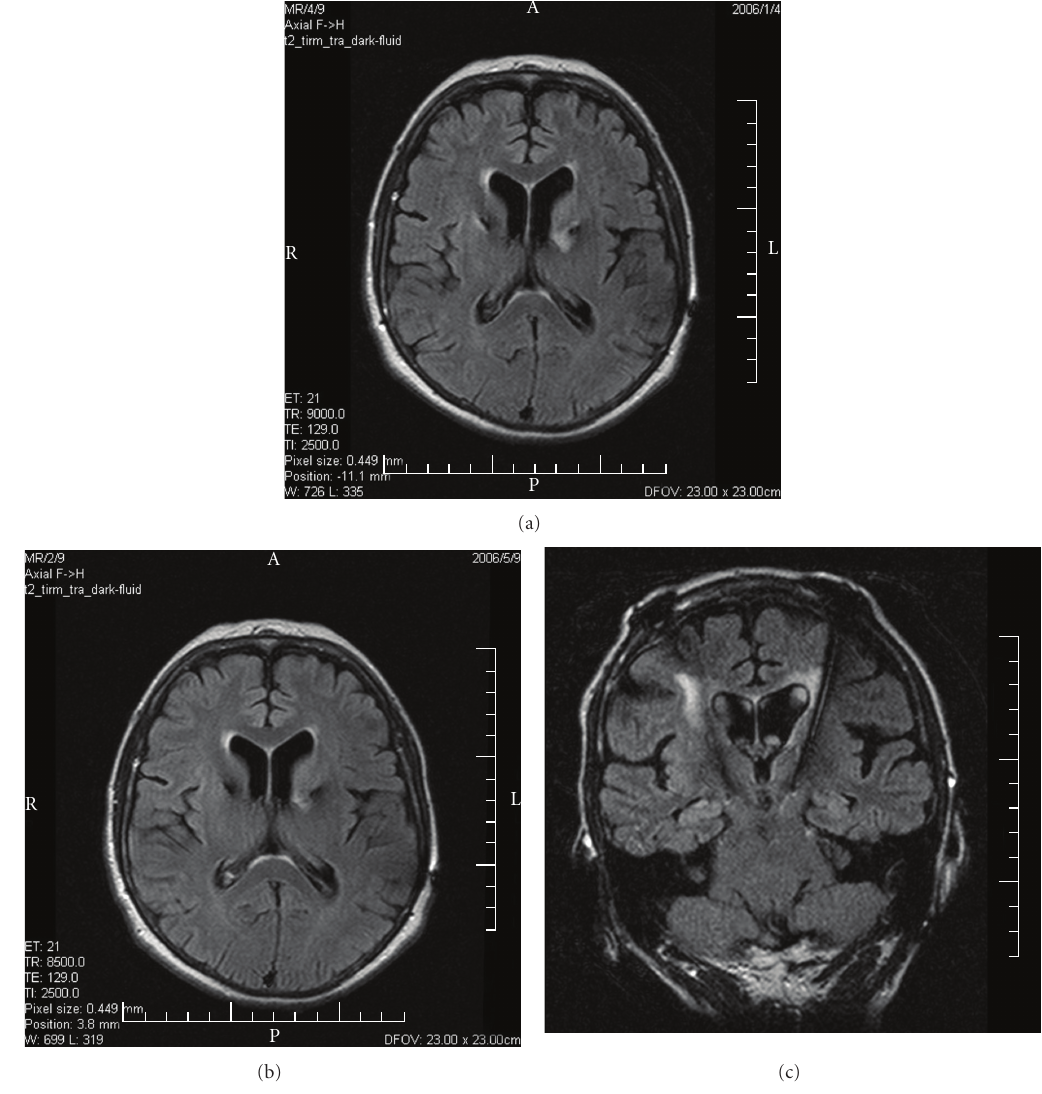
Figure 2: (a) Fluid-attenuated inversion recovery magnetic resonance imaging (FLAIR MRI) in January 2006 shows mild edema and bleeding in the anterior limb of the left internal capsule and left striatum. (b) FLAIR MRI in May 2006 still depicts signal changes along the left electrode trajectory in the internal capsule, medial edge of the lentiform nucleus reaching to the left thalamus. (c) FLAIR MRI in December 2008 demonstrates marked brain atrophy and white matter hyperintensities along the electrode